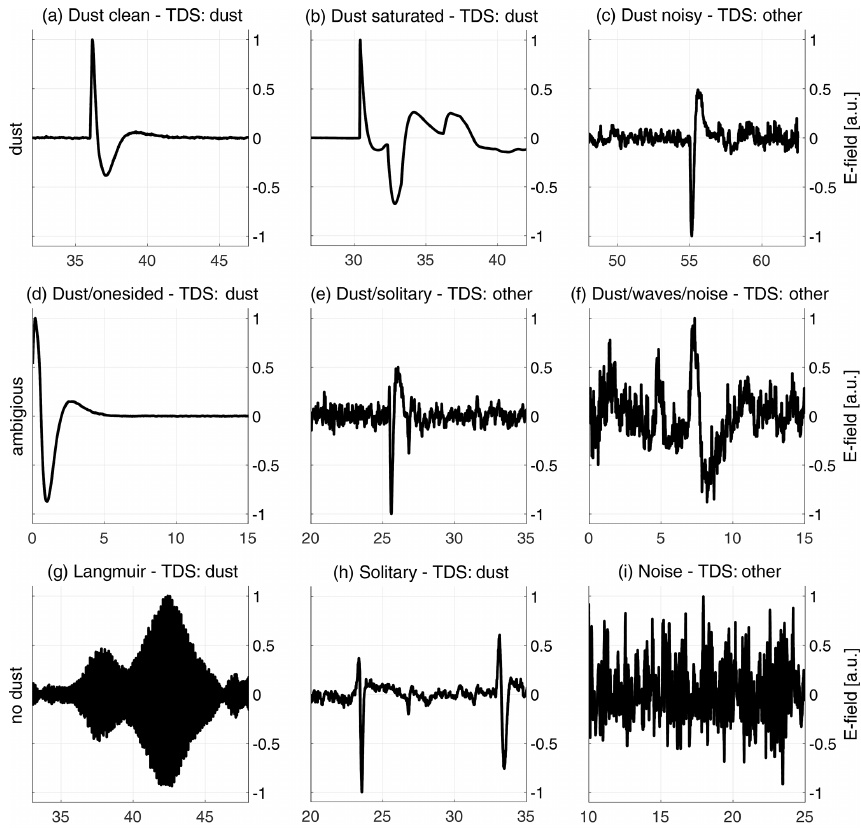
Figure 1. Waveforms recorded by the TDS receiver and measured by one of the RPW antennas. The signal label, classified by the TDS classification algorithm, is included for each snapshot in the subplot titles. The top row presents dust waveforms: (a) is a clean dust impact waveform; (b) shows a dust impact that saturates the receiver unit (or reaches the non-linearity limit); and (c) presents a weak dust impact signal that is strongly affected by noise. The middle row presents ambiguous waveforms: (d) might be a dust impact, but information is limited by the signal framing; (e) is likely a dust impact, but the signal shape resembles solitary waves and is strongly affected by noise; and (f) might be a dust impact, but noise and possible electromagnetic waves make the signal difficult to interpret. The bottom row presents waveforms without dust: (g) shows Langmuir waves, characterized by the high-frequency E-field oscillations with a lower-frequency amplitude modulation; (h) presents solitary waves, which sometimes resemble dust impact waveforms; and (i) shows a signal dominated by noise, without any clear features. Note that the full (63ms) snapshots are zoomed to 15ms intervals around the interesting features and that the signal amplitudes are normalized to ± 1 and centered around zero for illustrative